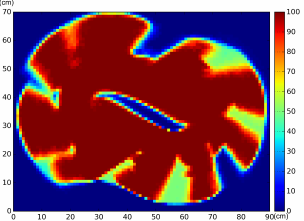
Figure 12. The total number of free observations.